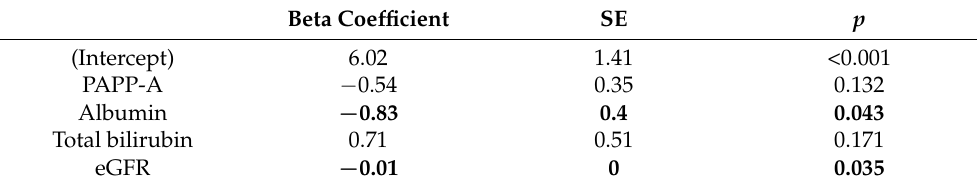
Table 3. Multivariable linear regression model predicting the severity of pregnancy-related hyperten- sive